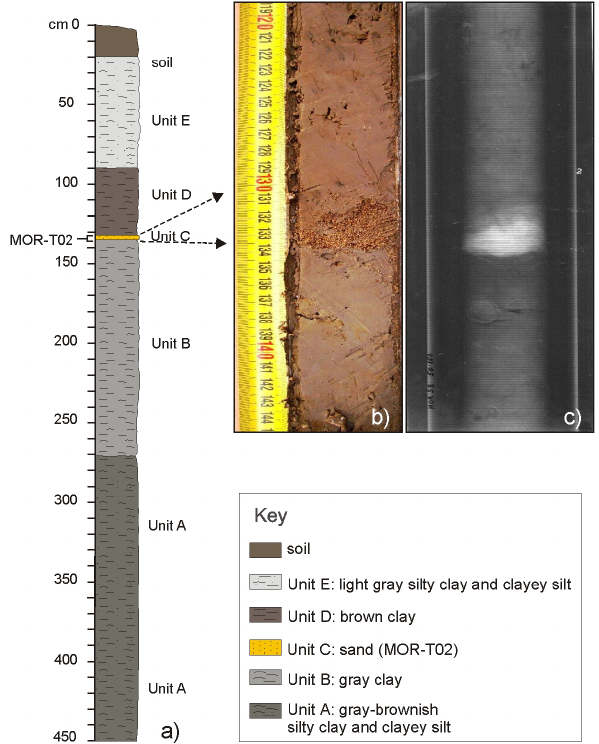
Fig. 3. (a) S3 core log representing the stratigraphy of the Pantano Morghella western side; (b) detail of the S3 core showing the sandy layer (UNIT C) within the silty clay; (c) X-ray film of the core.